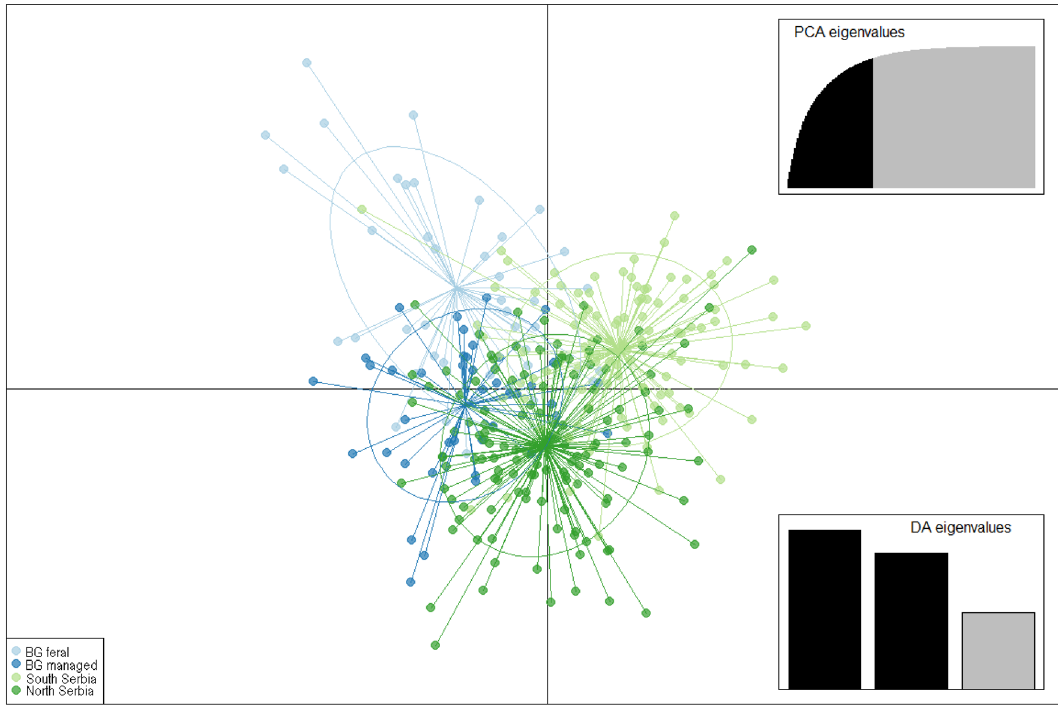
Figure 4. Discriminant analysis of principal components in which LDA was performed on the first 62 PCs (out of 197 PCs) cumulatively conserved 98.9% of the total variance. The first and second linear discriminants are presented in the